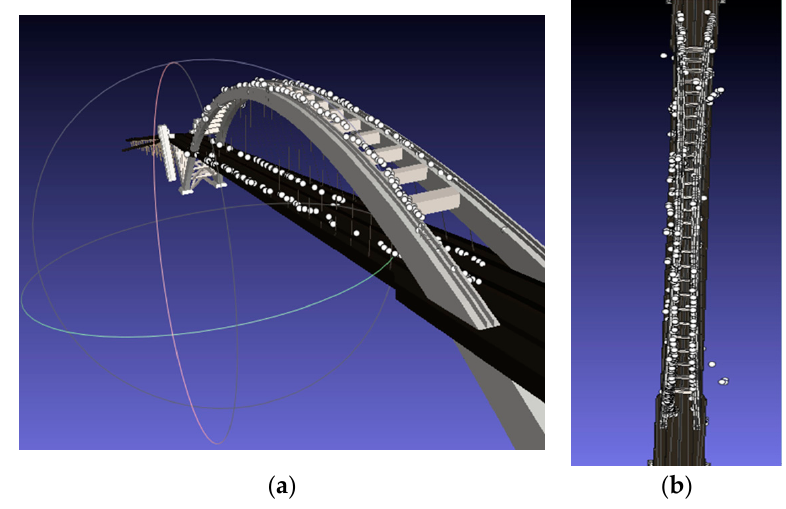
Figure 5. PSs (white dots) superimposed on the bridge model in Meshlab: ( a ) side view; ( b ) top view. Table 3. Key parameters of the estimated bridge structure from iterations 1, 3, and 5 compared with the bridge model data (only direct measurements are listed).